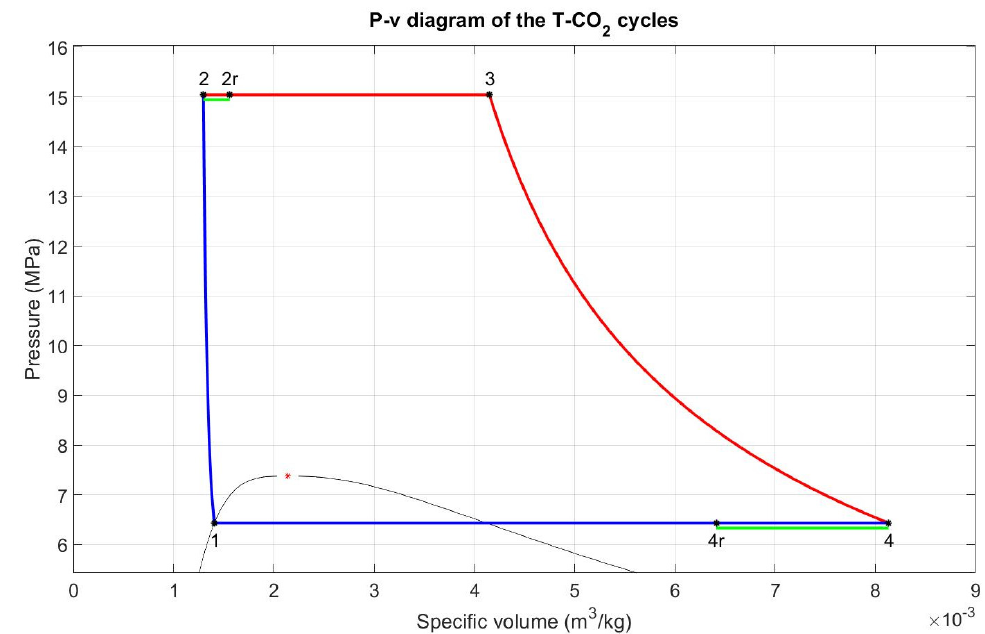
Figure 2. Pressure-volume (P-v) diagram of the T-CO 2 cycles.